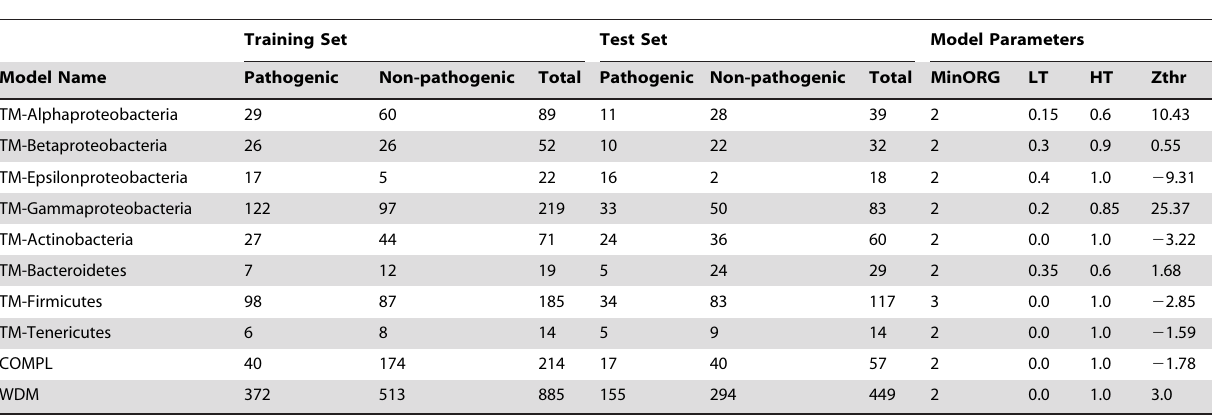
Table 1. Training, test data and model parameters.